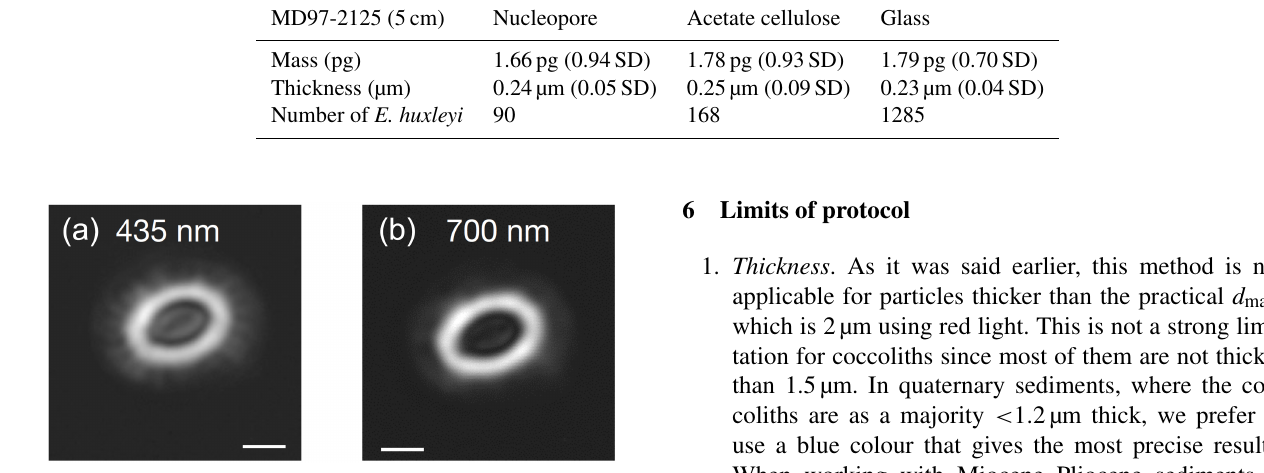
Plate 1. Images of a coccolith of Emiliania huxleyi captured at wavelengths 435 (a) and 700nm (b) . White bars are 1µm long. Brightness has been adapted to enhance the contrast between back- ground and elements from the distal